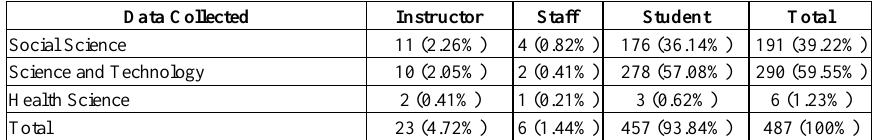
Table 3. Data collected classify by career and related academic disciplines.